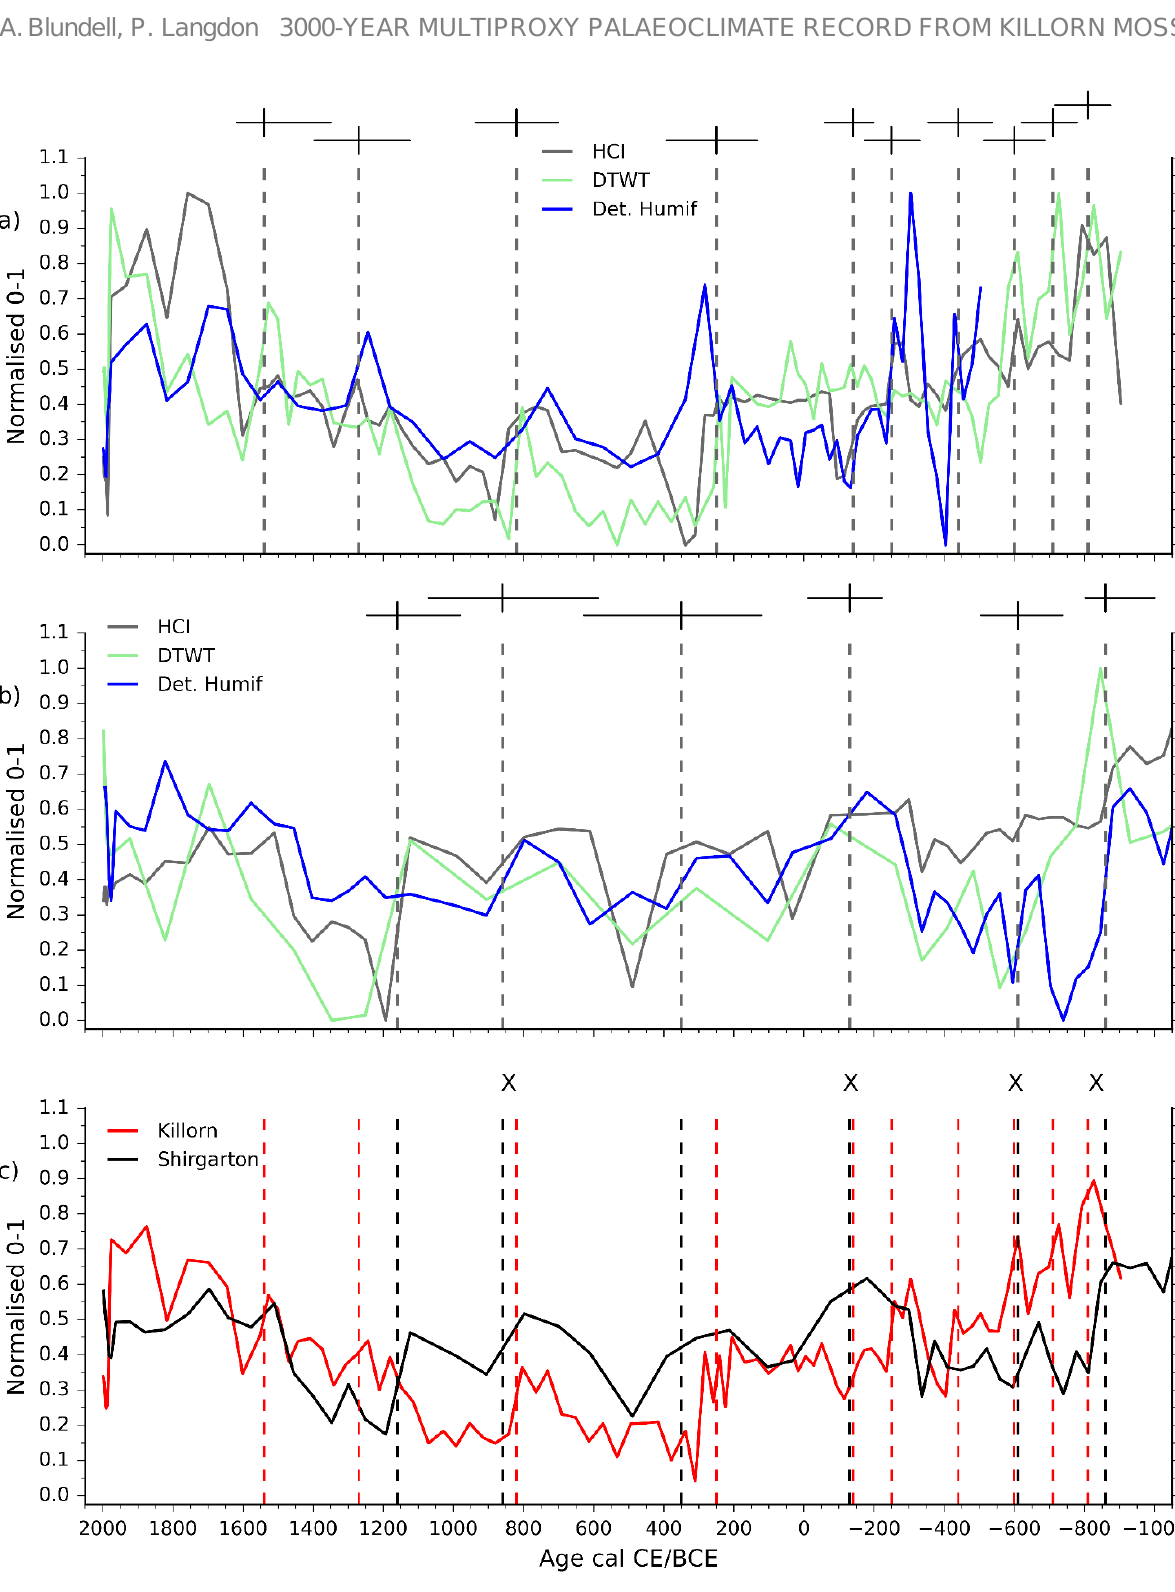
Figure 7. Comparison of normalised proxy data (HCI - grey, DTWT - green, detrended humification - blue) versus age CE/BCE together with highlighted wet shifts (grey dashed vertical lines) for a) Killorn Moss, b) Shirgarton Moss and c) the mean of proxy data from Killorn (red) and Shirgarton (black) and the respective wet shifts from both in corresponding-coloured vertical dashed lines. Modelled ages and age ranges for each shift are shown above the plots in a and b with the small vertical lines representing the median of the age range. Proxies are normalised between 0-1. Wet shifts within 50 years of each other between the two sites are highlighted with